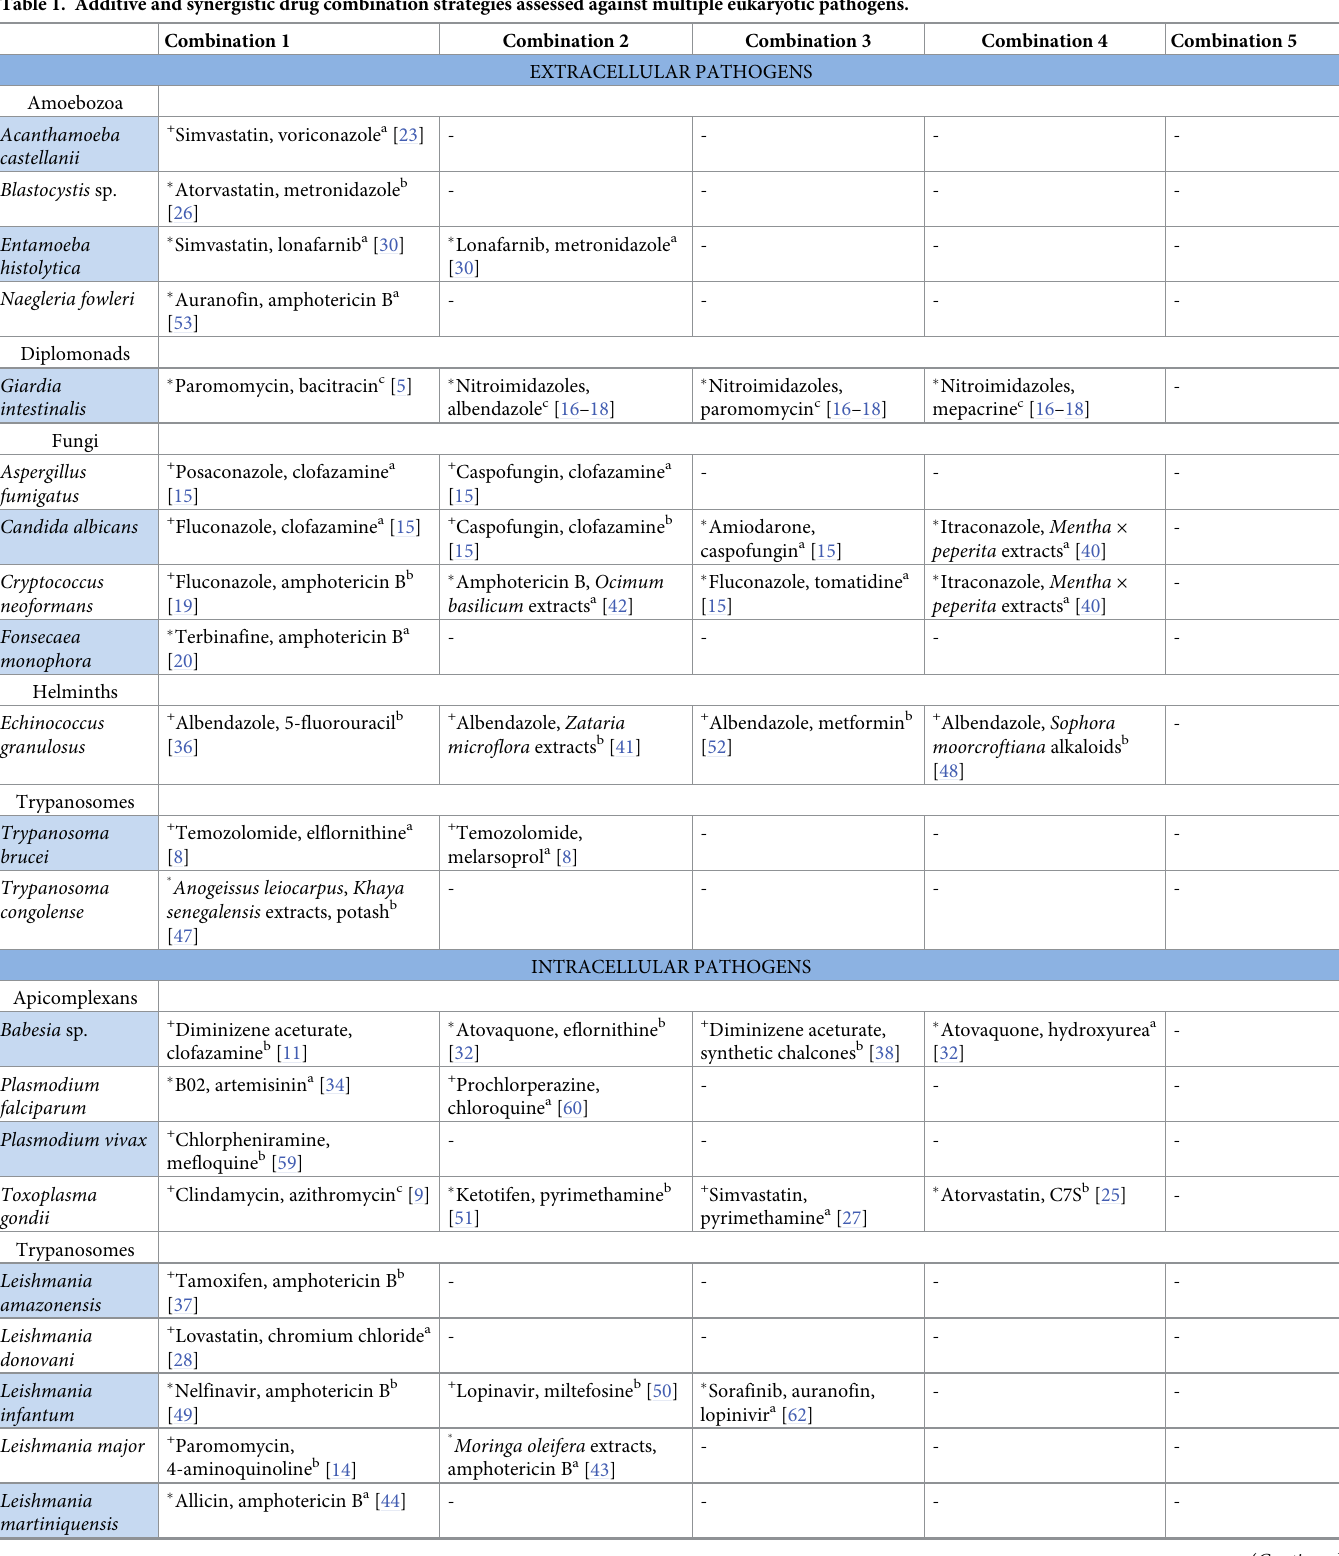
Table 1. Additive and synergistic drug combination strategies assessed against multiple eukaryotic